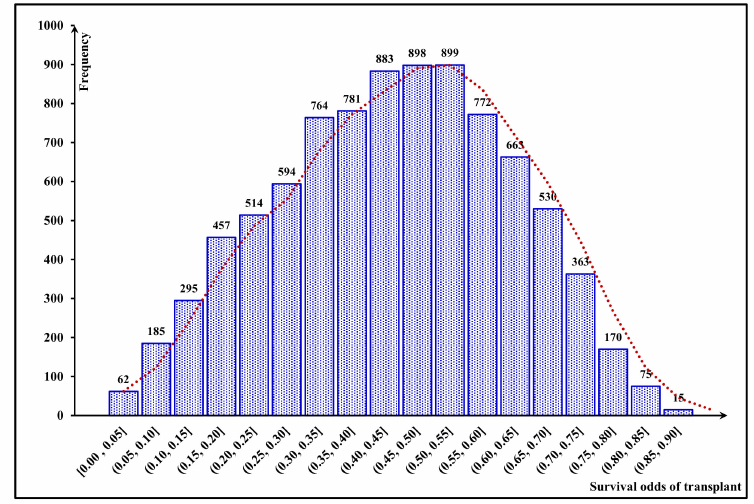
Figure 5. Frequency distribution of 10-year graft-survival